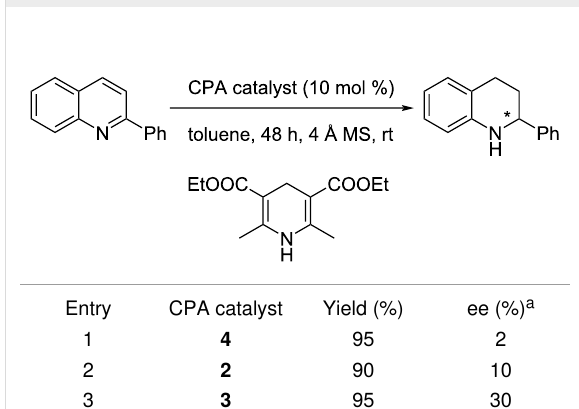
Table 1: P -stereogenic CPAs in the transfer hydrogenation of quino-